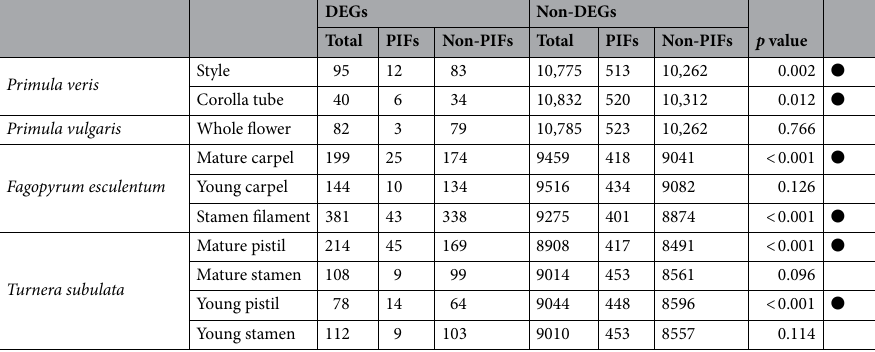
Table 2. Enrichment analysis of PIF-regulated genes among DEGs in ten samples. Black circles at the end of the rows indicate samples in which DEGs are significantly enriched in PIF-regulated